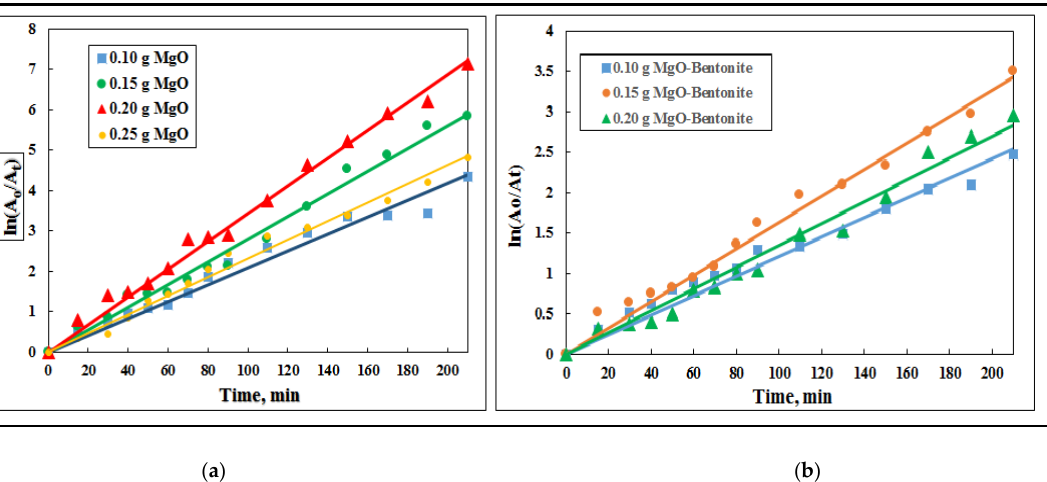
Figure 7. Plot of ln (A 0 /A t ) vs. reaction time, t, at different doses of ( a ) MgO NPs and ( b ) MgO/Ben nanocomposite under the experimental conditions.